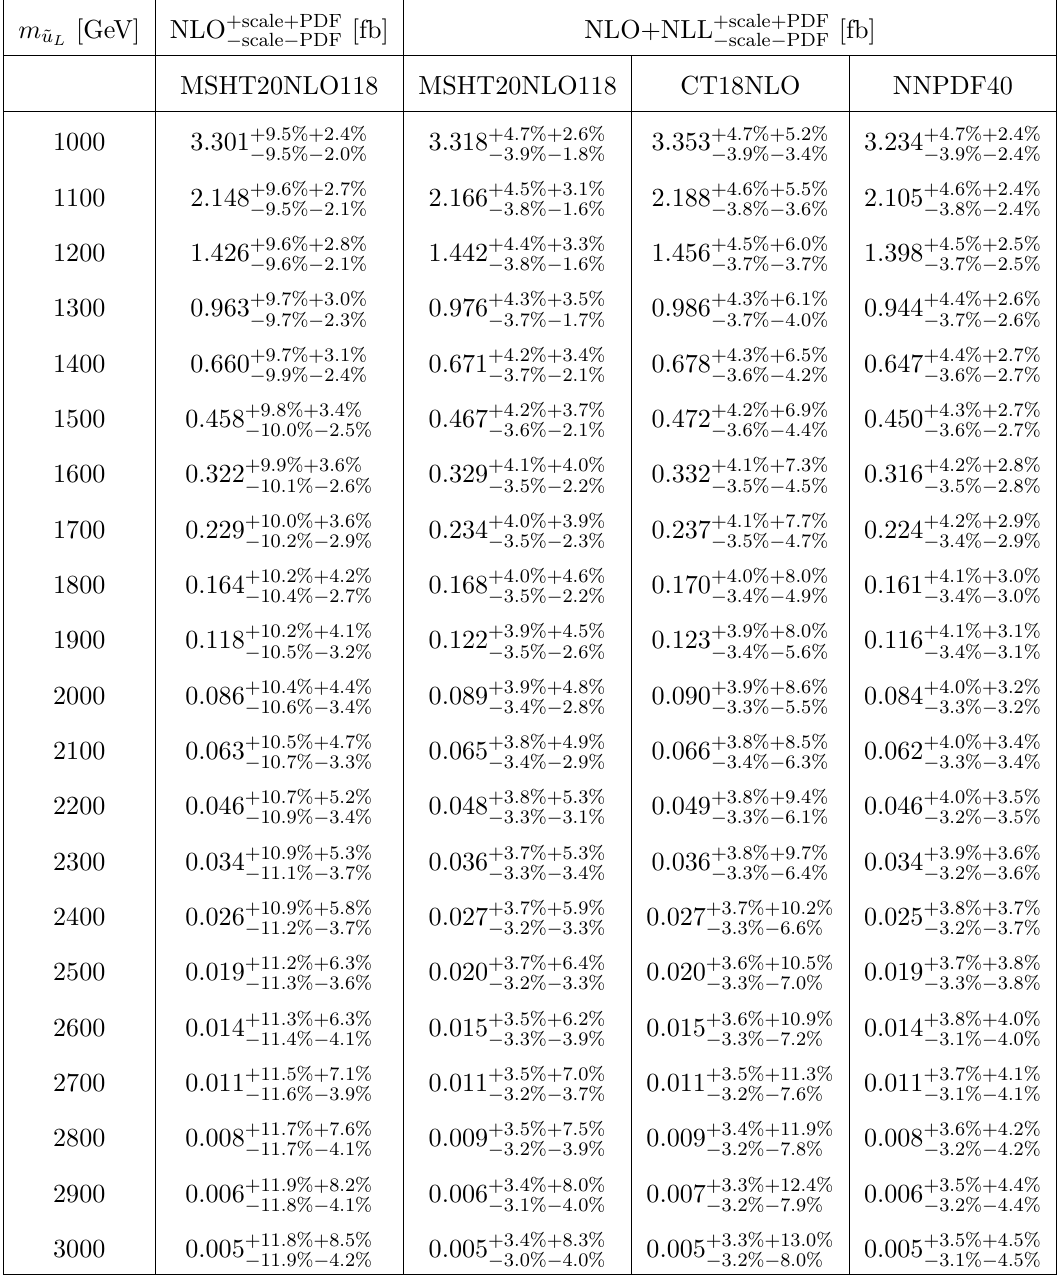
√ at S = 13 TeV at NLO and NLO+NLL for 1